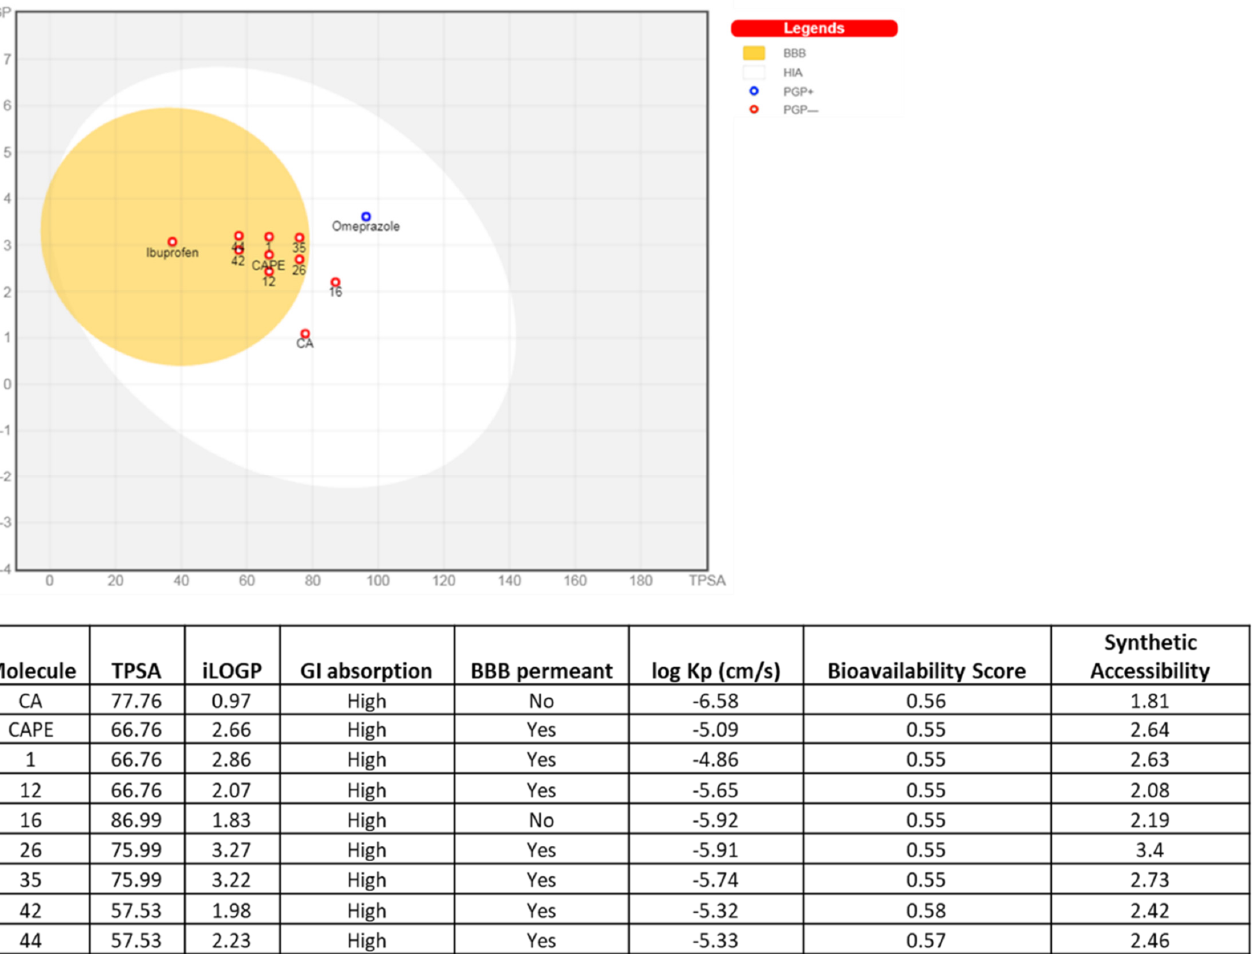
Figure 9. Metabolism and absorption of key antioxidant esters and ketones of selected phenolic acids.